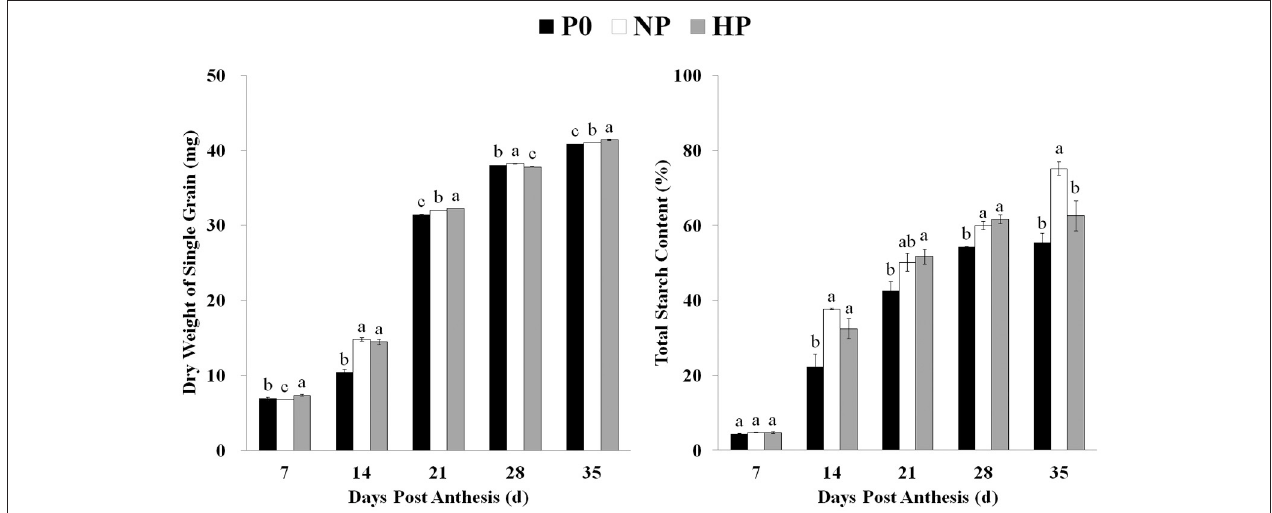
FIGURE 1 | Total starch content and dry weight of single grains in P0, NP, and HP. Values are means ± S.E. of three replications. Columns with different letters are significantly different at p < 0.05. P0: 0kg P ha − 1 ; NP: 46kg P ha − 1 ; HP: 92kg P ha − 1 .